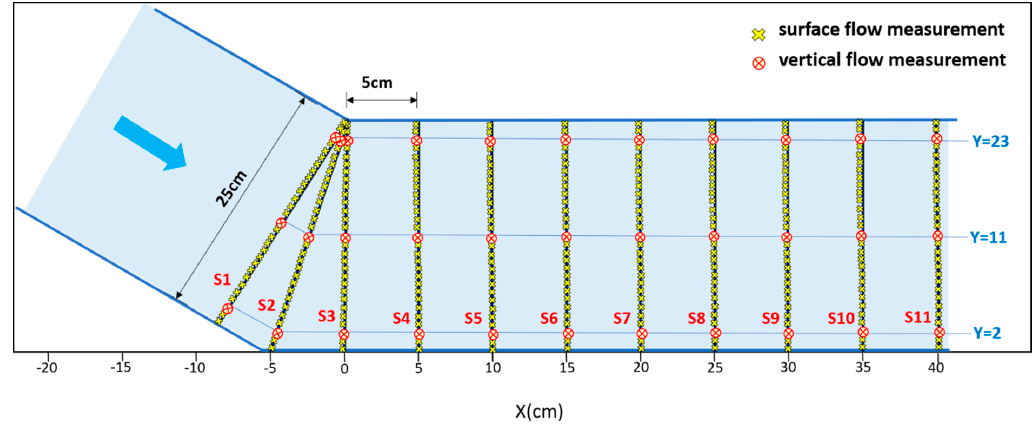
Figure 4. The flow field measurement of surface and vertical velocity.